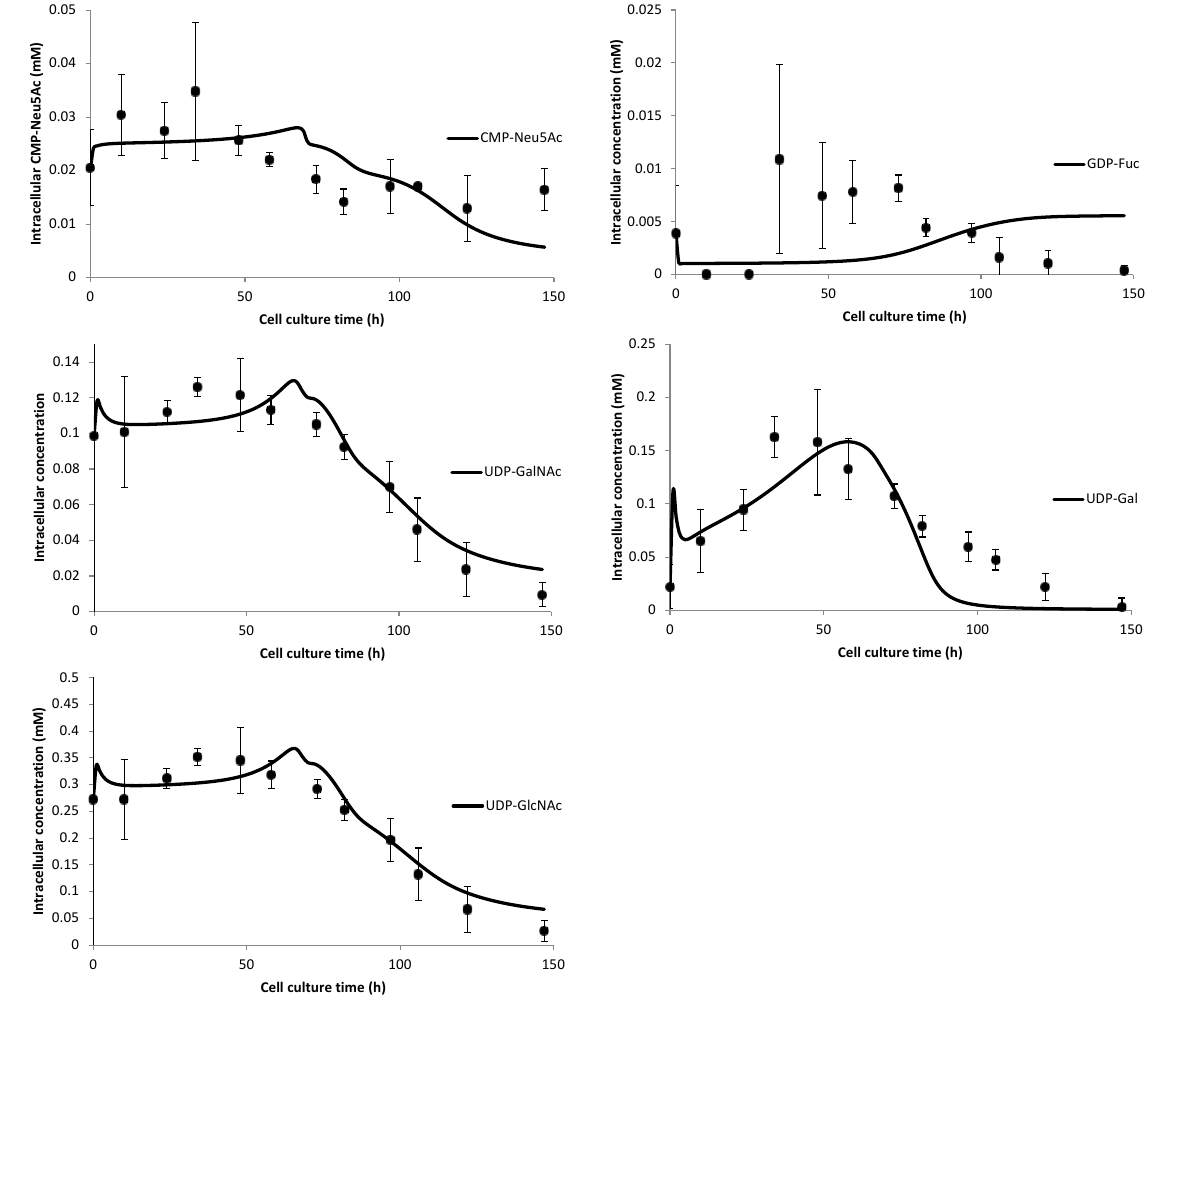
Figure 6. Experimental data compared with generated fits from the mechanistic bottom-up approach nucleotide sugar synthesis model. Fits for intracellular CMP-Neu5AC concentration ( top left ), intracellular GDP-Fuc concentration ( top right ), intracellular UDP-GalNAc concentration ( center left ), intracellular UDP-Gal concentration ( center right ) and intracellular UDP-GlcNAc concentration ( bottom left